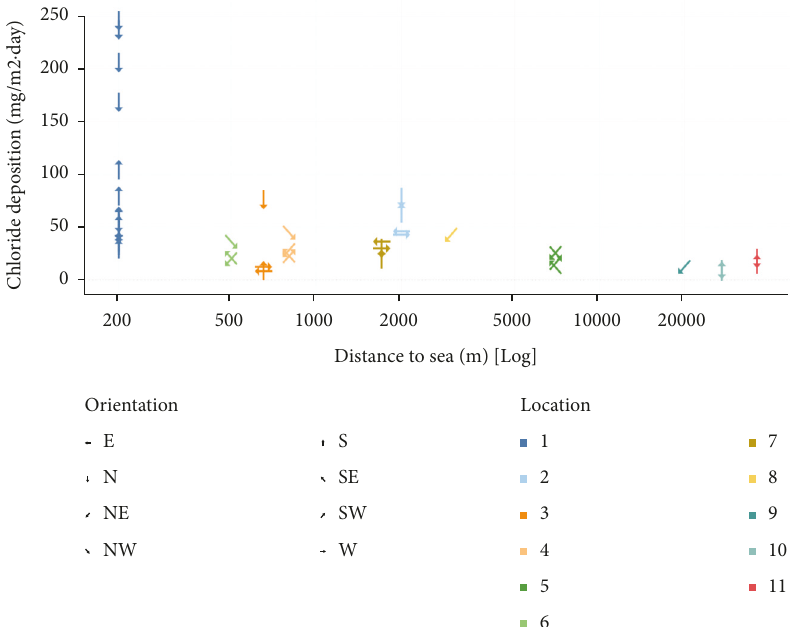
Figure 9: Chloride deposition as a function of distance from the sea in meters (logarithmic scale).